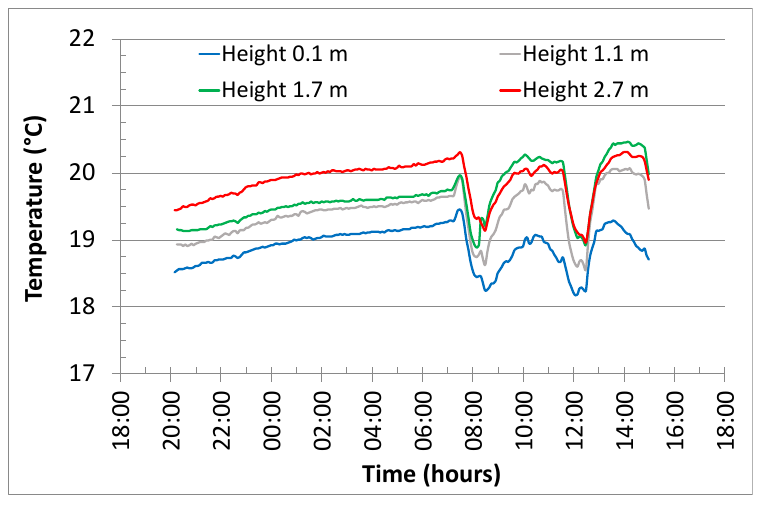
Figure 16. Measured vertical temperature profiles for the field experiment.